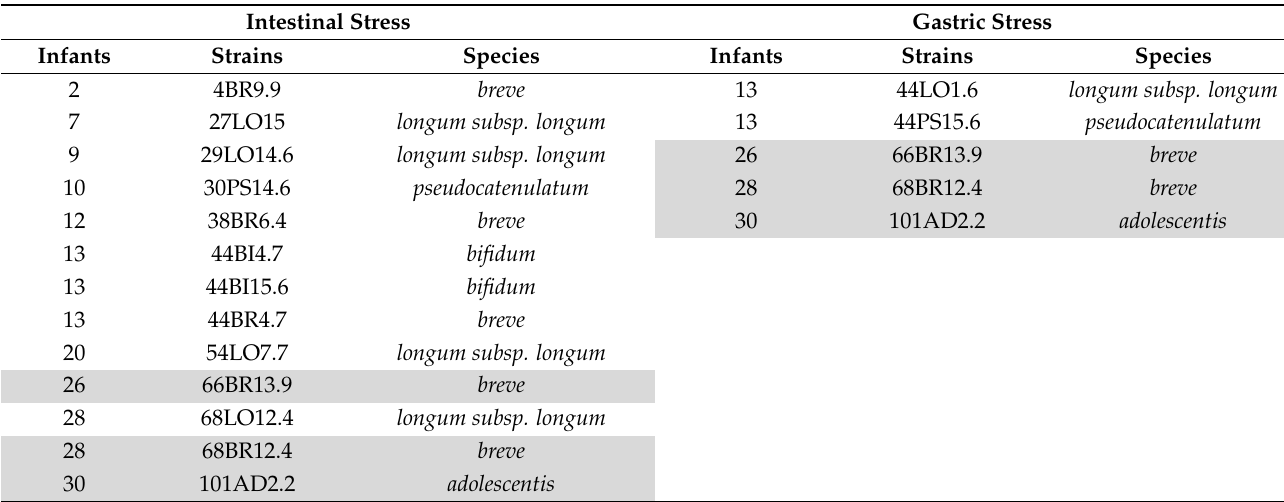
Table 2. Tolerant bifidobacteria strains towards intestinal and gastric